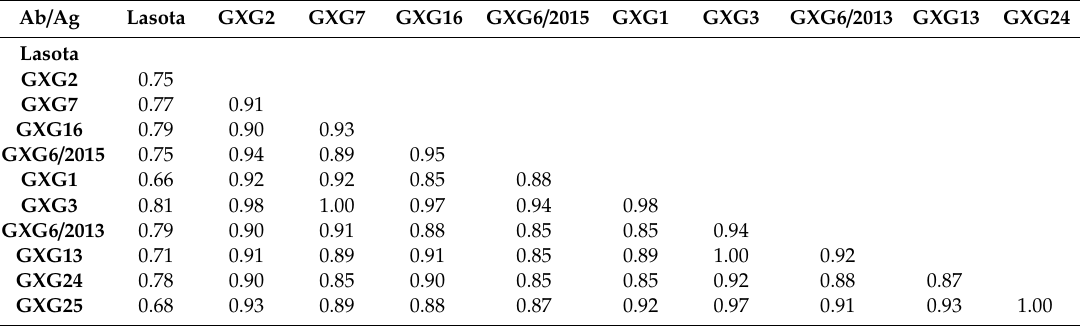
Table 3. Serum cross-reactivity R value results by hemagglutination inhibition assay. Ab /